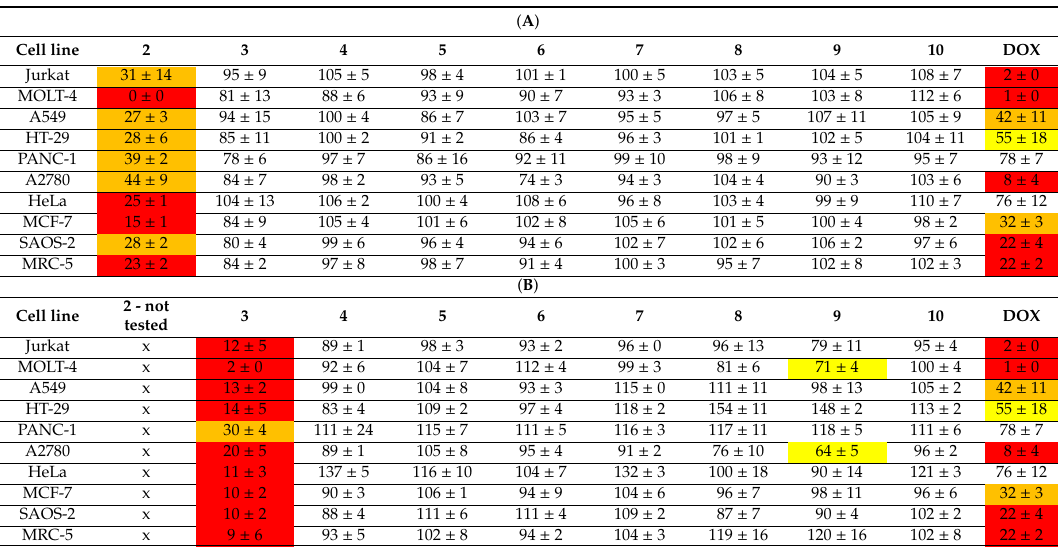
Table 2. Cytotoxic e ff ect of novel compounds in vitro. Values represent cell viability after treatment with 10 µ M ( A ) and 100 µ M ( B ) of the tested compounds. The results are expressed as relative viability (%) when compared to an untreated control (100%). Compound 2 was not tested at 100 µ M. DOX—doxorubicin (1 µ M). Each value represents the mean of three independent experiments ± SD. Values from the intervals 0–25% (red color), 26–50% (orange color) and 50–75% (yellow color) are highlighted with di ff erent colors.